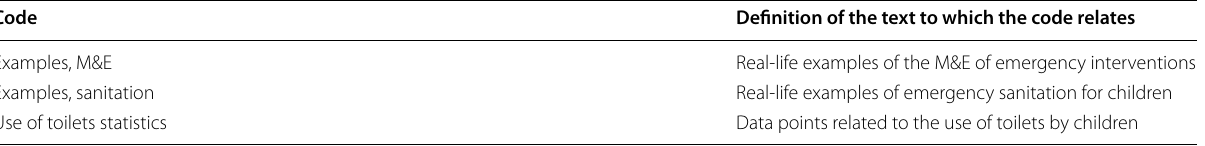
Table 2 Codebook for Criterion 2b